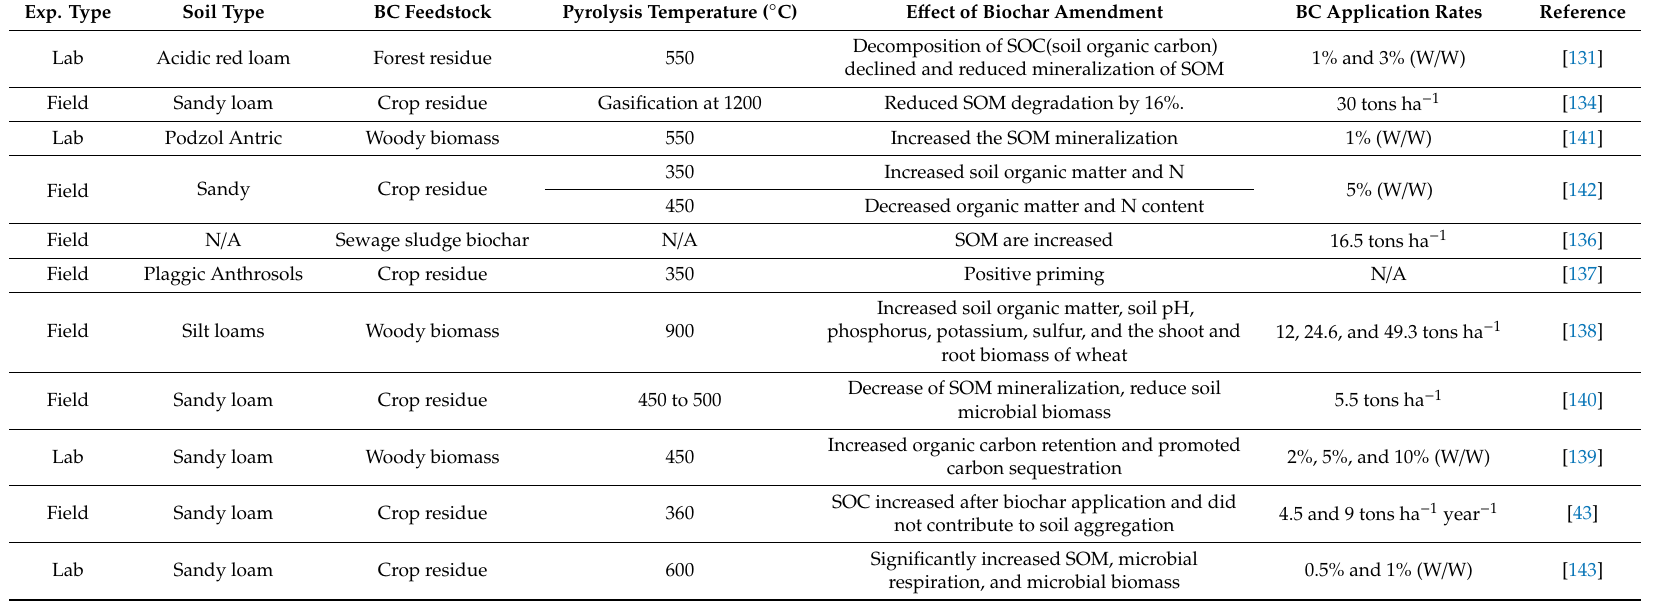
Table 3. Selected recent studies summarizing the e ff ect of biochar on soil organic matter (SOM). Exp.